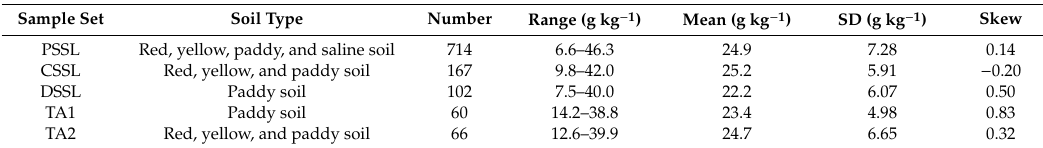
Table 1. Main characteristics of soil organic carbon (SOC) for all soil samples from the three soil libraries and two target